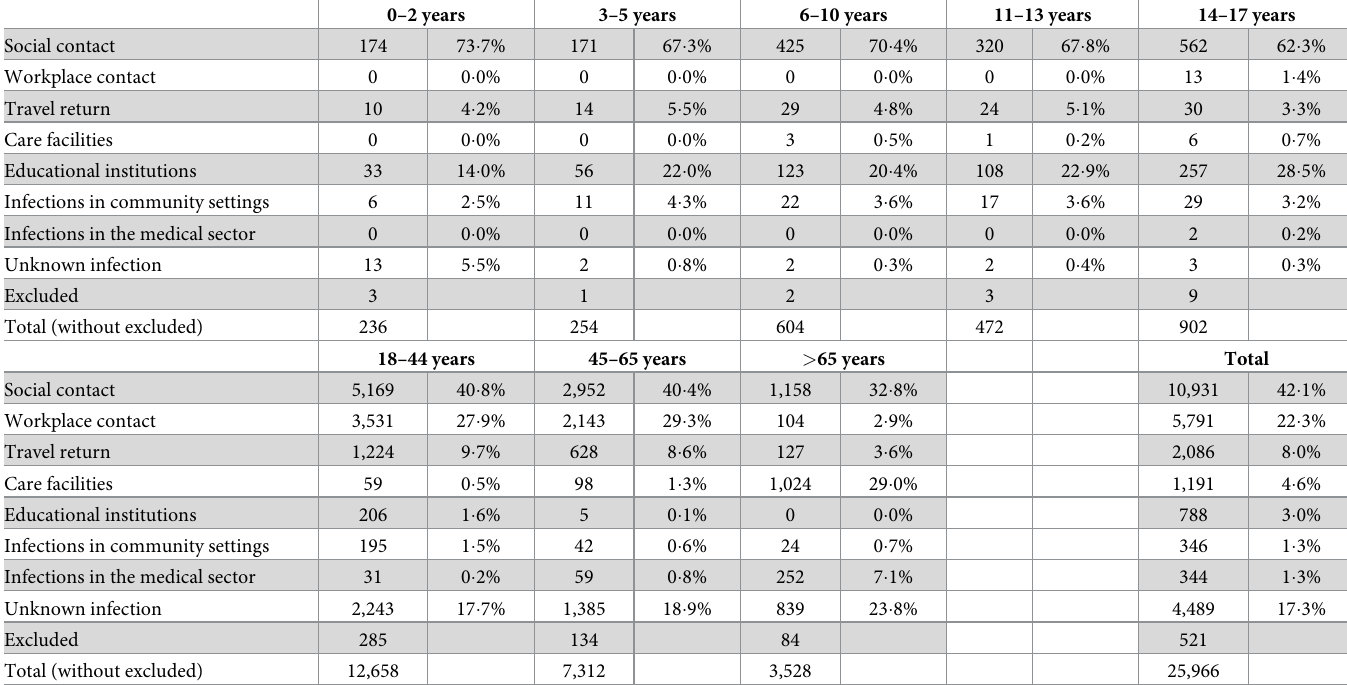
Table 3. Transmission routes at different